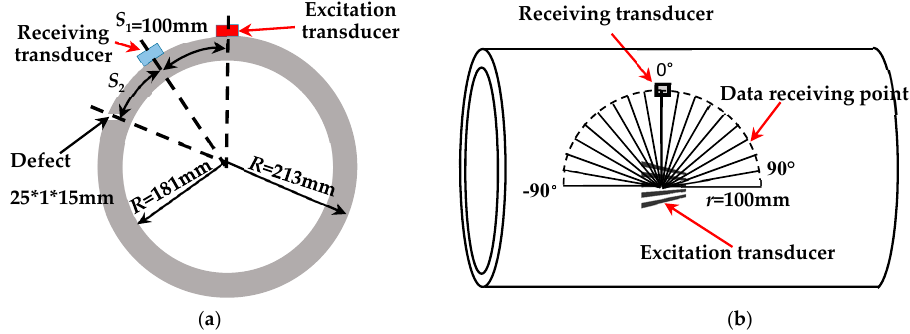
Figure 13. Test system diagram ( a ) Defect inspection test diagram; ( b ) Directivity test diagram.